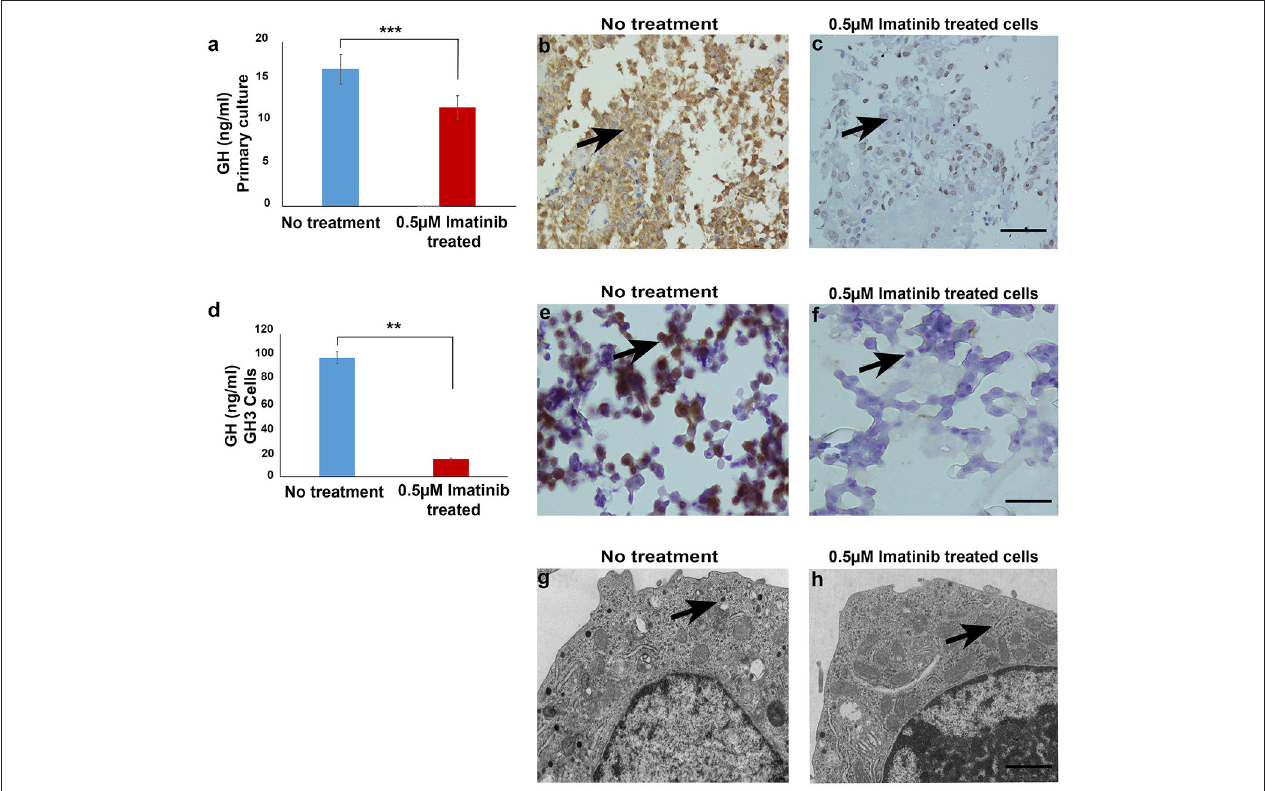
FIGURE 1 | (a) Bar diagram showing reduction in growth hormone levels in culture media after treatment with 0.5 µ M imatinib in primary culture of somatotropinoma cells ( P < 0.0001). (b,c) Representative image of immunohistochemistry with anti-GH antibody on treated and untreated primary somatotropinoma culture. (d) Bar diagram showing reduction in GH levels in culture media of GH3 cell line after treatment with 0.5 µ M imatinib ( P < 0.01). (e,f) IHC of GH3 cells showing intense GH positivity in untreated and no GH staining in treated cells (20X). (g,h) Ultra-structural analysis of GH granules using electron microscopy between treated and untreated GH3 cells (6000X). ** P < 0.01; *** P < 0.0001.